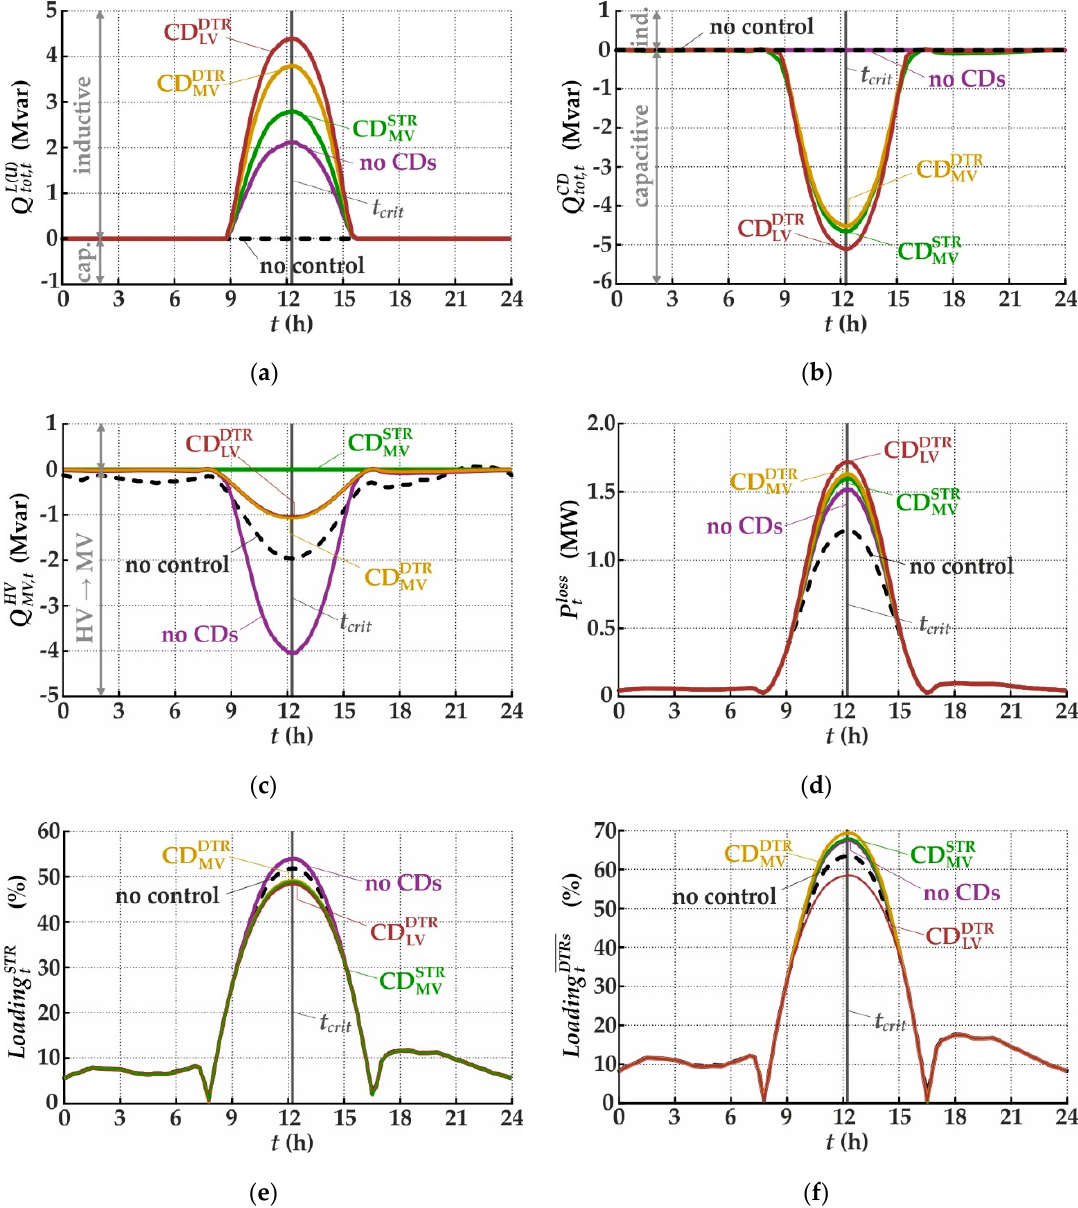
Figure 13. Behaviour of the distribution grid with overhead line conductors in MV level for a 24 h time horizon and different control strategies: ( a ) Q -consumption of L ( U )s; ( b ) Q -contribution of CDs; ( c ) Q -exchange between HV_ and MV_link-grid; ( d ) active power losses; ( e ) STR loading; ( f ) mean DTR loading.